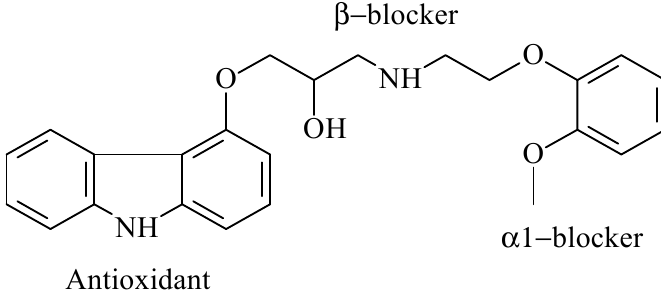
Figure 1. Chemical structure of carvedilol.